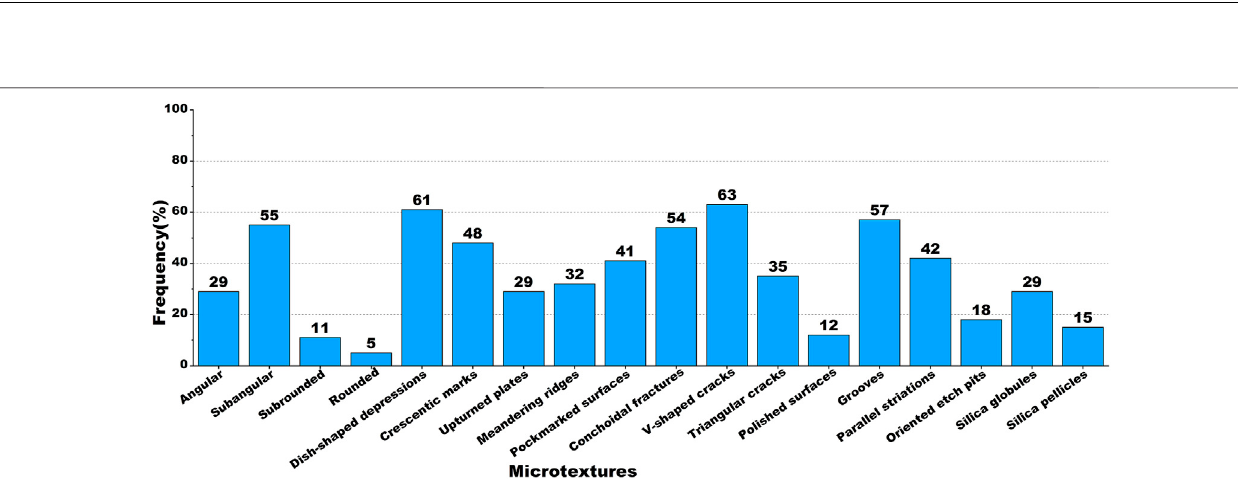
FIGURE 8 | Frequencies of different microtextures identi fi ed in XG pro fi